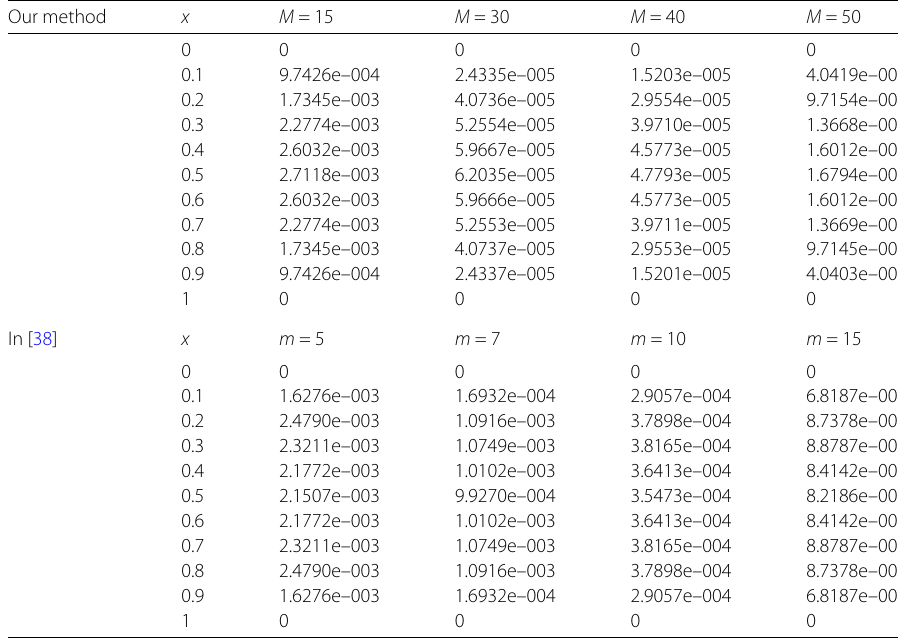
Table 4 The maximum absolute error of the proposed method for different values of M and N = 11, n = 4, α = 1.95 corresponding to Problem 4 at t = 1 and in